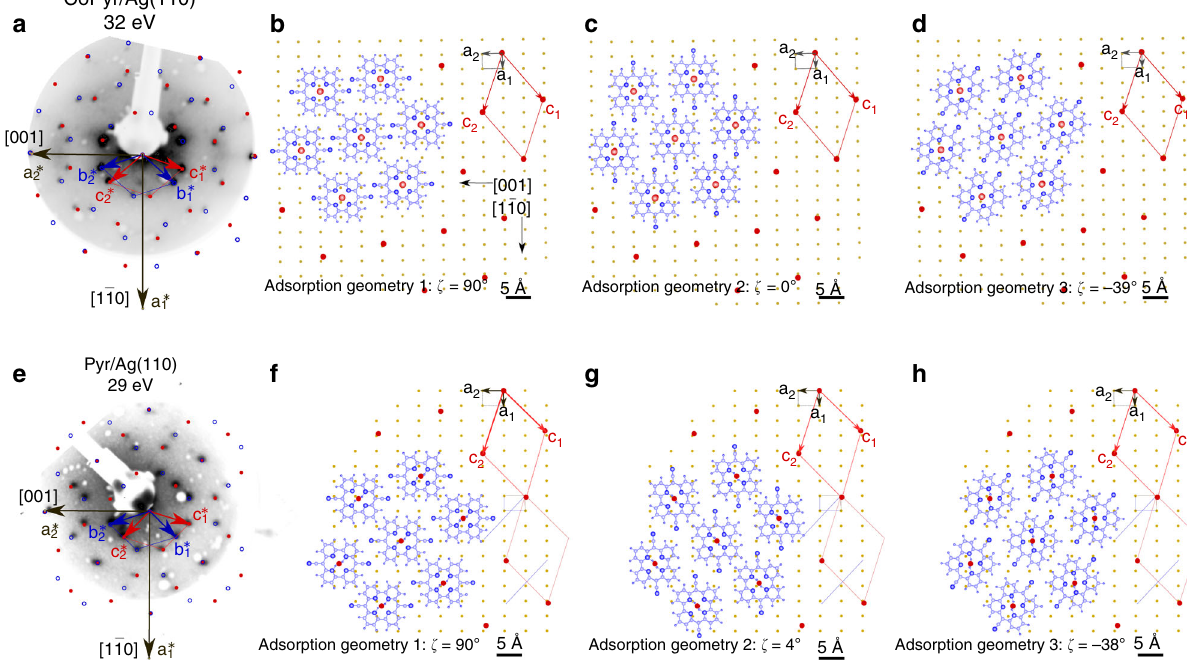
Fig. 2 Analysis and simulation of low-energy electron diffraction (LEED) data. a – d Co-pyrphyrin (CoPyr) on Ag(110). a LEED pattern acquired at 32 eV beam energy. Overlay: simulated reciprocal lattices of molecular adlayers (lattice 1 (blue), lattice 2 (red)). b – d Visualisation of possible CoPyr molecular registries on Ag(110) in lattice 2. e – h As in a – d , but for pyrphyrin (Pyr) on Ag(110)